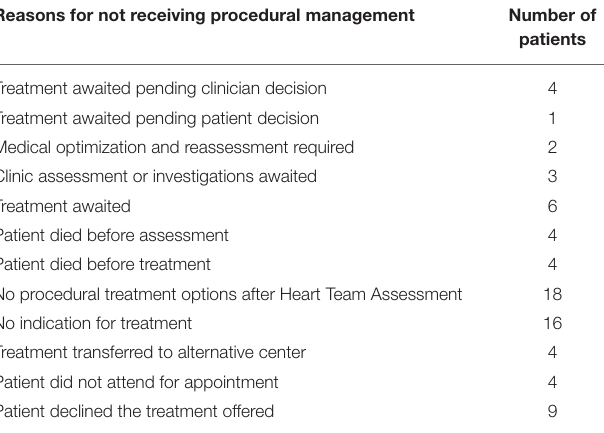
TABLE 2 | Reasons for not receiving procedural